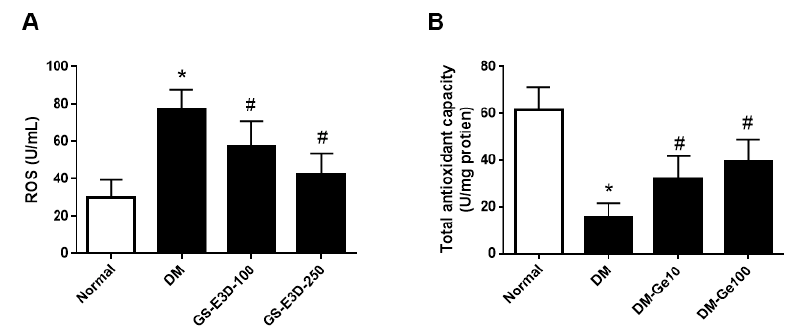
Figure 3. The levels of reactive oxygen species (ROS) ( A ) and total antioxidant capacity ( B ) in renal tissues were assessed by ELISA. Data are presented as the mean ± standard deviation (n = 8). * p < 0.05 vs. Normal group; # p < 0.05 vs. DM group.